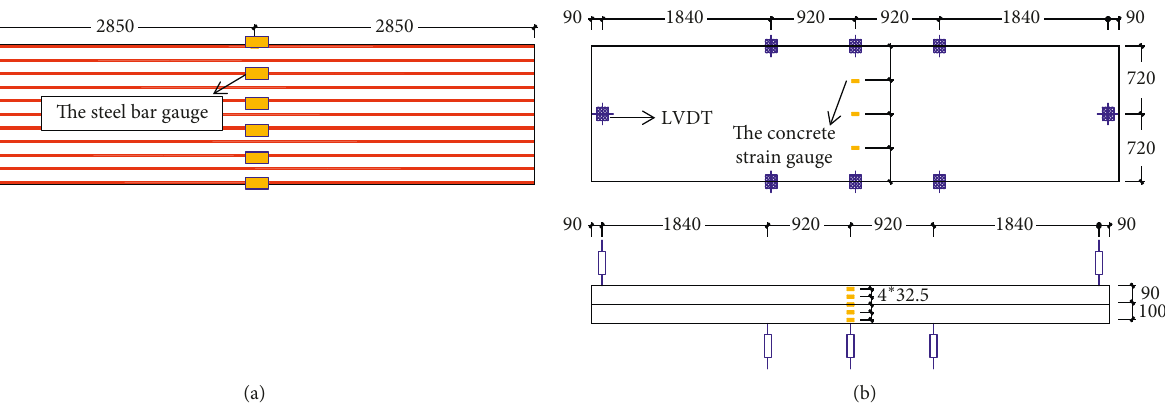
Figure 6: Locations of the strain gauges: (a) reinforced strain gauge arrangement; (b) concrete strain gauge